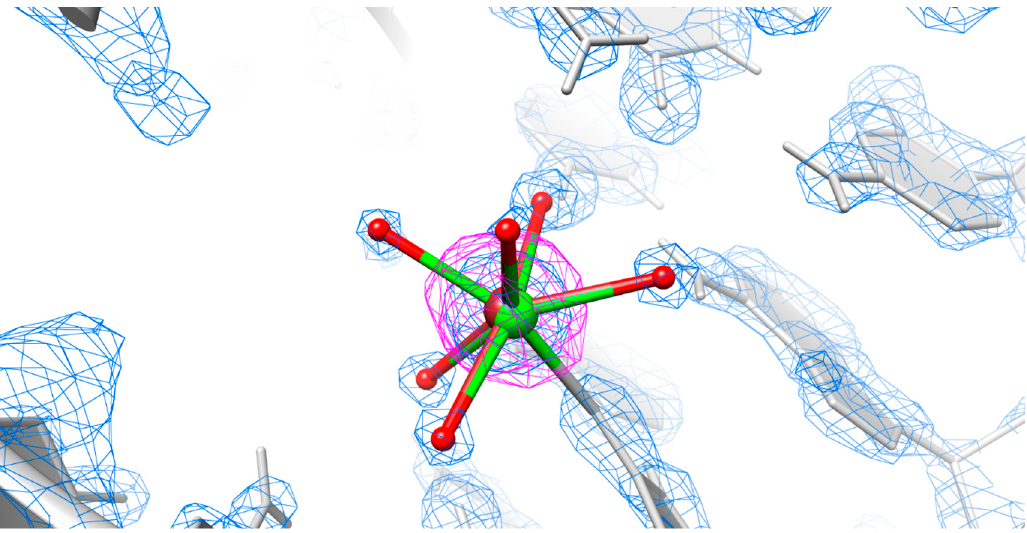
Figure 5. Representative model for the co-existence of Ca 2+ and Cu 2+ . The RNA crystal structure demonstrates the mixed state of Ca 2+ (green) and Cu 2+ (brown) in the central part of the major groove. The anomalous difference map for Cu 2+ shown as a pink mesh contours the atoms at the 4 σ level and the electron density map shown as blue meshes contours the atoms at the 3 σ level. Coordinated water molecules are shown as red spheres.